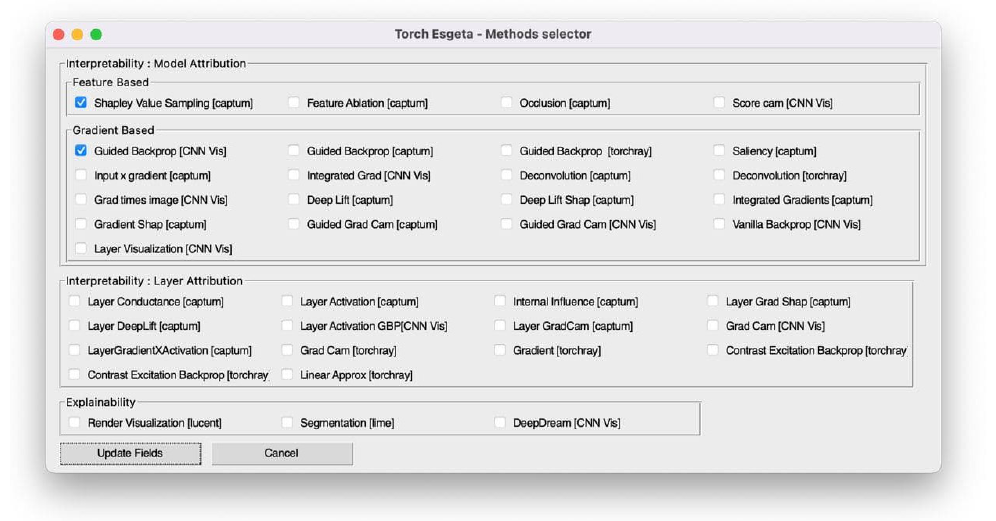
Figure 3. GUI: Method selection. Choosing which methods are to be applied on given